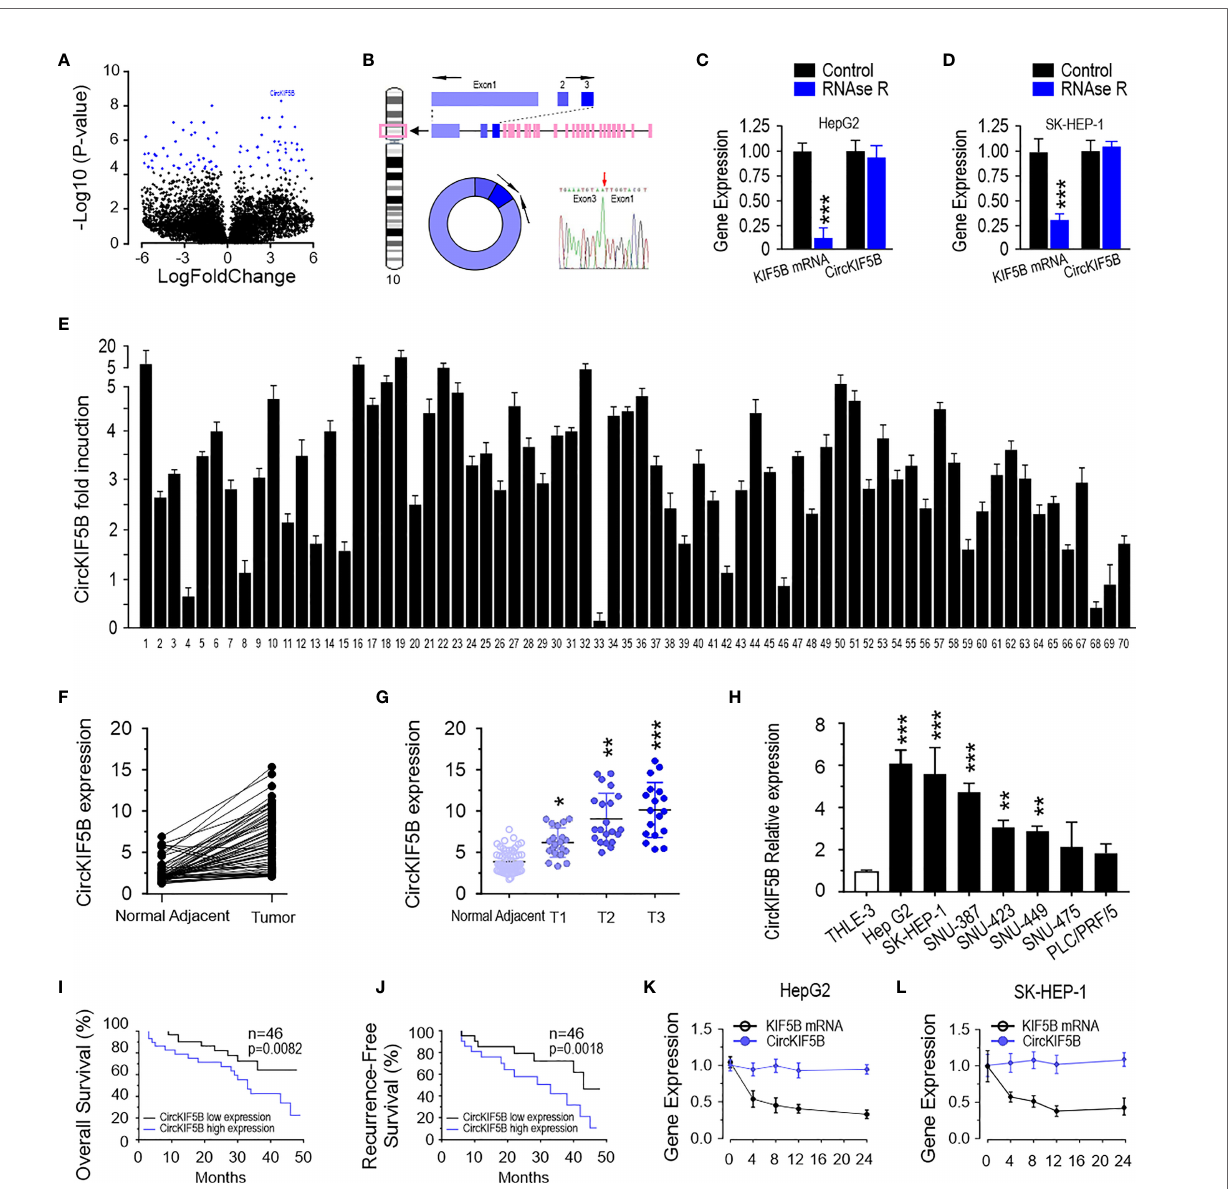
FIGURE 1 | CircKIF5B is up-regulated in liver cancer tissue. (A) A volcano plot for fold changes of circRNAs level in liver cancer tissues compared adjacent normal tissues. (B) Schematic illustration indicating circKIF5B formation by the circularization of KIF5B exons 1, 2, and 3. (C) CircKIF5B and KIF5B transcripts levels in the presence or absence of RNase R treatment by qRT-PCR in HepG2 and SK-HEP-1 (D) cells. (E) The relative expression of circKIF5B by qRT-PCR analysis with divergent primers in liver cancer tissues compared with adjacent normal tissues in 70 pairs of liver cancer patients. (F) The expression of circKIF5B in 70 pairs of human samples (E) with the Mann – Whitney test. (G) Correlation between circKIF5B level and the stage of clinical classi fi cation in 70 cases of liver cancer and noncancerous tissues. (H) The circKIF5B level in liver cancer cell lines and normal liver cell line. (I, J) The curves of overall survival (I) and recurrence-free survival (J) association with circKIF5B level in 46 liver cancer patients. (K, L) CircKIF5B and linear KIF5B transcript level after actinomycin D treatment. *p < 0.05, **p < 0.01, ***P <